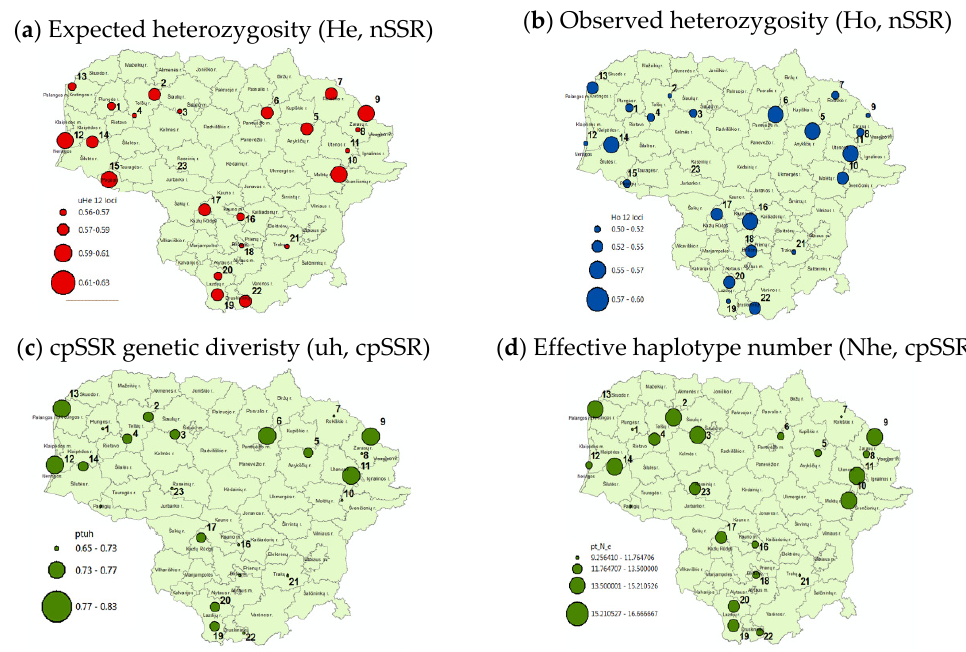
Figure 5. Geographical distribution of the main within-population genetic-diversity parameters for nuclear SSR (upper ( a , b )) and cpSSR (lower ( c , d )) loci. The population locations are marked by the cycles scaled by the parameter values. For cpSSR, uh is diversity measure on allelic level corresponding to He for nSSR data; the effective haplotype number is genetic-diversity measure at haplotype corresponding to He for nSSR. Higher genetic diversity of northeastern and northwestern populations is observed for both nuclear and chloroplast DNA loci.